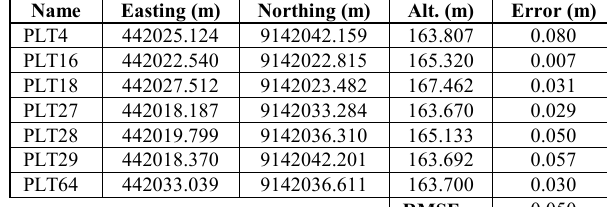
Table 3. Residual table for the check points for the